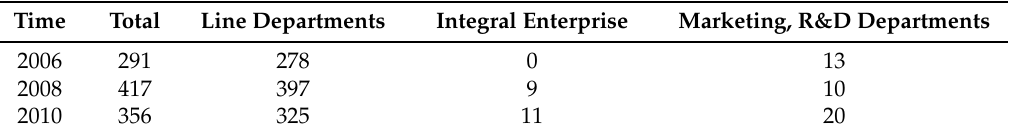
Table 1. The number of all transferred enterprises by different pathways from the south to the north of Jiangsu during 2006–2010. Time Total Line Departments Integral